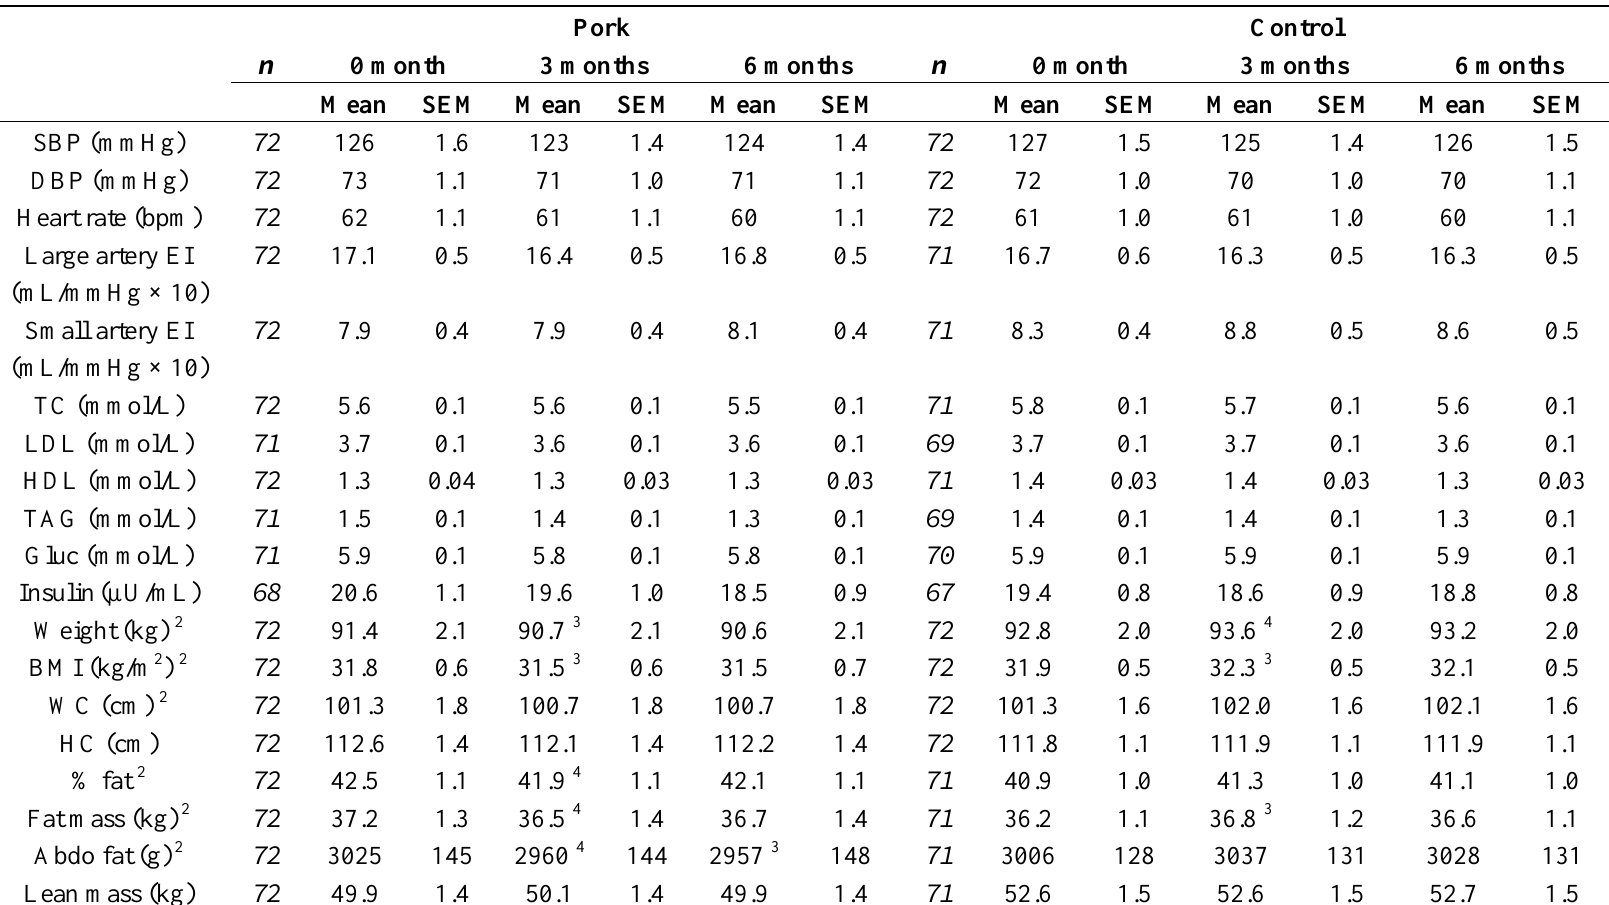
Table 3. Average values for blood vessel function, blood lipids, glucose and insulin and body composition of volunteers in the pork and control groups at baseline and 3 and 6